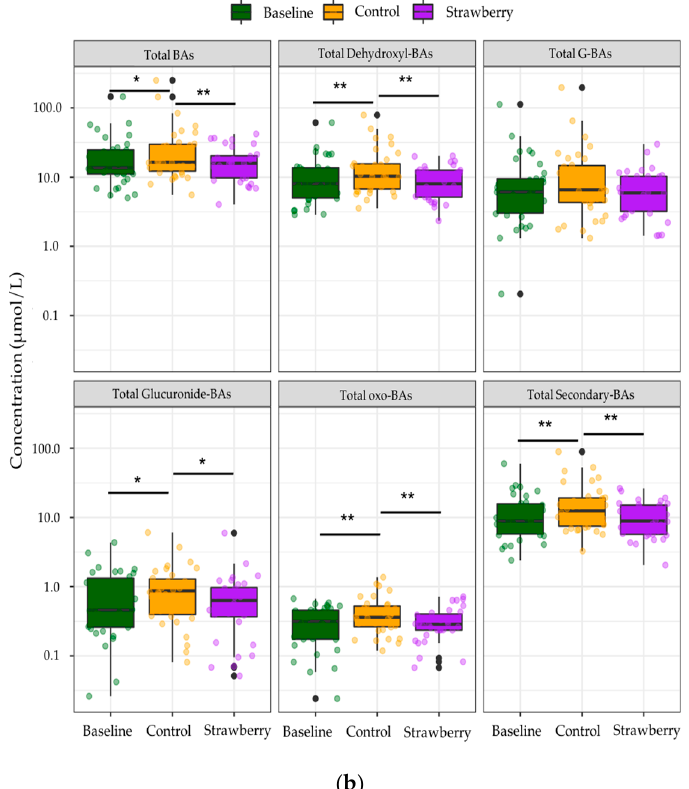
Figure 4. Changes in bile acids after 4-week control or strawberry beverage intake compared to baseline (week 0). ( a ) Changes in individual bile acids. Data are shown as the mean and standard error of the mean. ( b ) Changes in bile acid in different subgroups. Data are shown as the mean and standard error of the mean. * p < 0.05, ** p < 0.01. The black dots are the outliers, which are defined as outside 1.5 times the interquartile range (IQR) above the upper quartile (Q3) and below the lower quartile (Q1) (Q1 − 1.5 × IQR or Q3 + 1.5 × IQR).